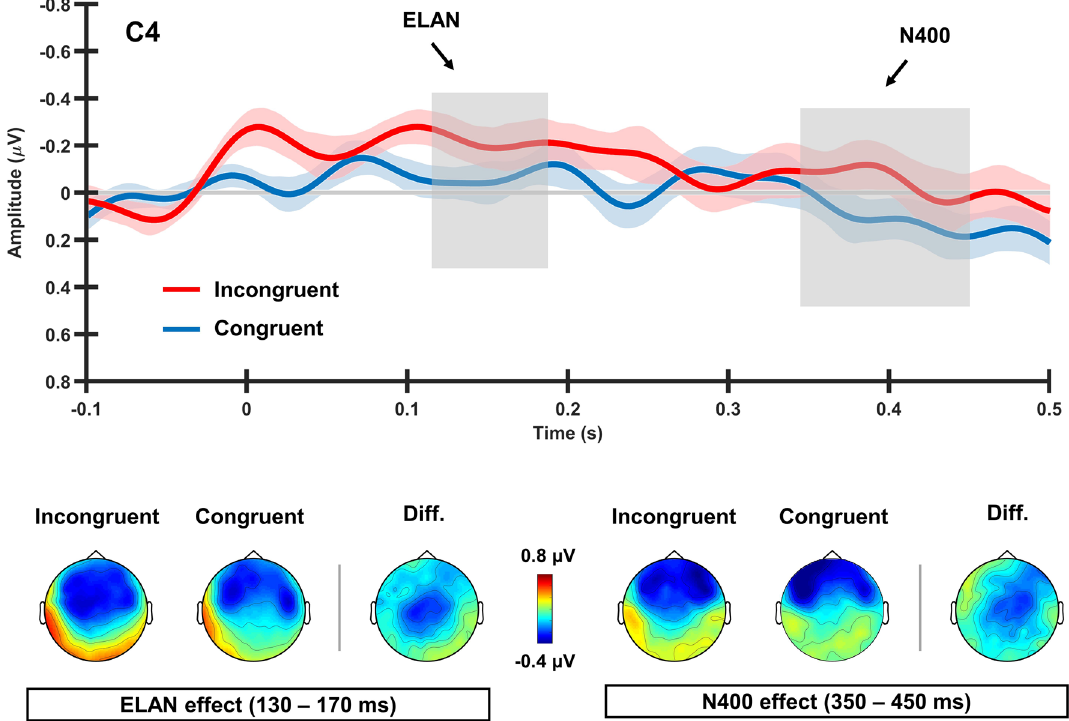
Figure 3. Averaged ERP waveforms and topographic maps for Congruent and Incongruent conditions. Arrows indicate early and late Voice Congruency effects at 150 ms and 400 ms after verb-suffix onset on a representative scalp site (C4), compatible with ELAN-like and N400-like components,